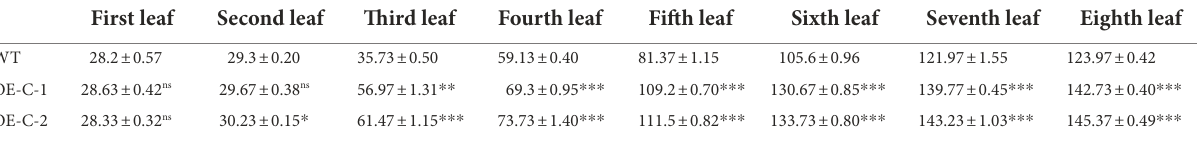
TABLE 1 Cotton leaf area (cm 2